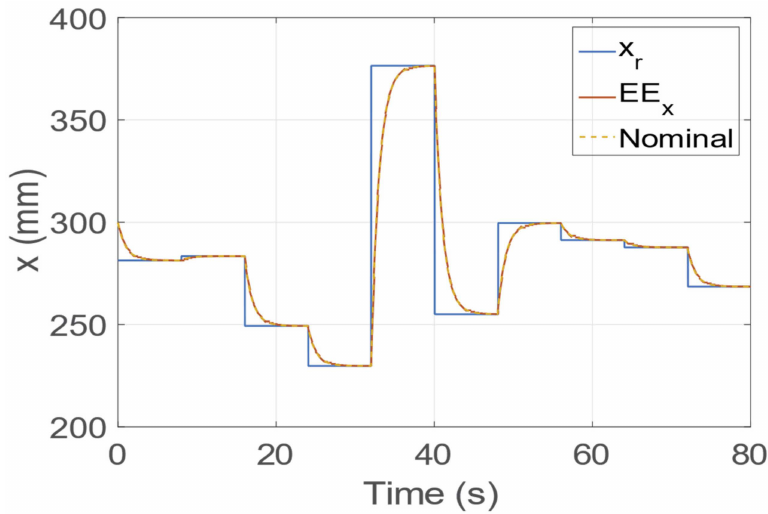
Figure 7. Dynamic evolution of the x coordinate with the relative reference and nominal